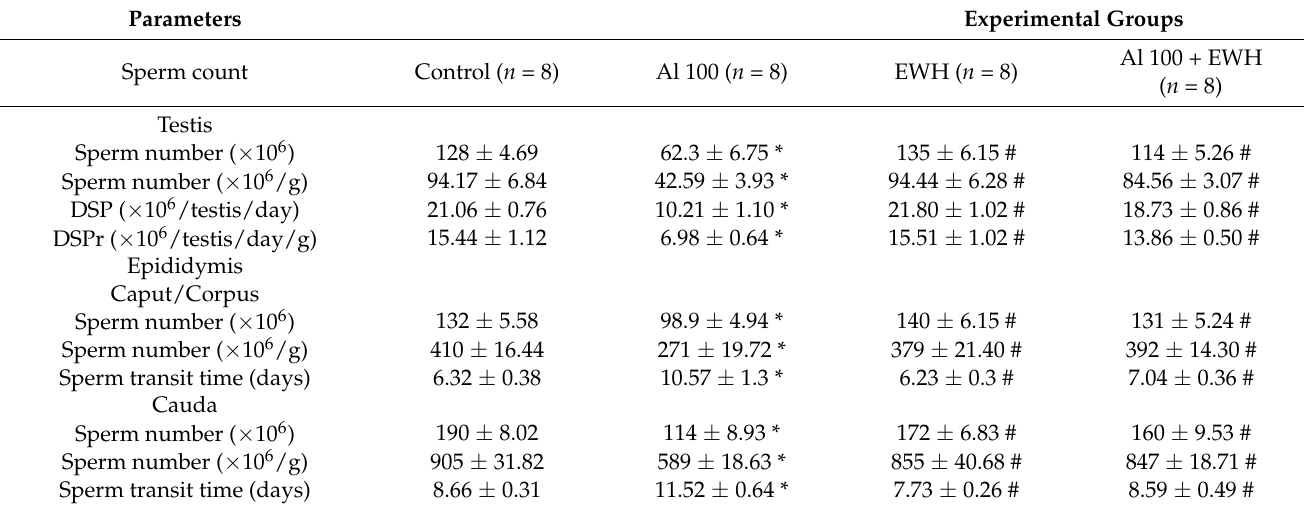
Table 4. Effect of EWH on sperm counts in testis and epididymis of rats exposed to AlCl 3 at 100 mg/kg for 42